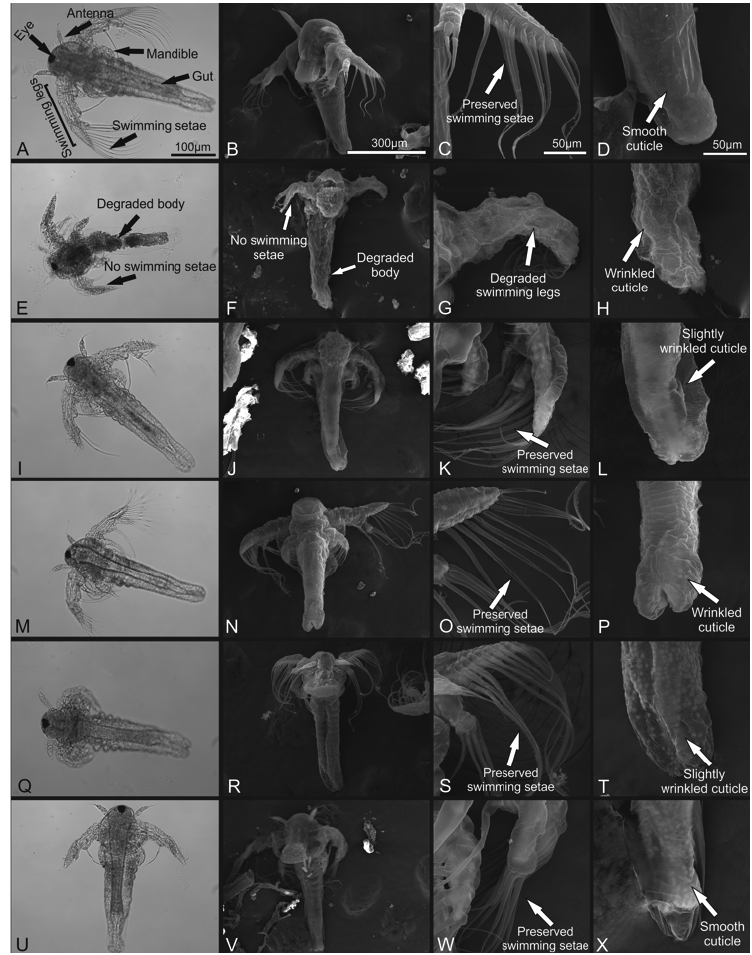
Figure 8. Optical and scanning electron microscopy of A. salina nauplii within 24 h exposure on protective effect test. ( A – D ) Negative control (artificial seawater); ( E – H ) positive control (H 2 O 2 127.45 mM); I-L fresh cashew apple bagasse (CAB) 1000 μ g.mL − 1 ; M–P 75 W/cm 2 CAB 1000 μ g.mL − 1 ; ( Q – T ) 226 W/cm 2 sonicated CAB 1000 μ g/mL ; ( U – X ) 373 W/cm 2 CAB 1000 μ g/mL . Note severe damage on nauplii exposed to hydrogen peroxide presenting degraded body, no swimming legs, and wrinkled cuticle. Bars: ( A , E , I , M , Q , U )—500 μ m; ( B – D , F – H , J – L , N – P , R – T , V – X )—50 μ m.